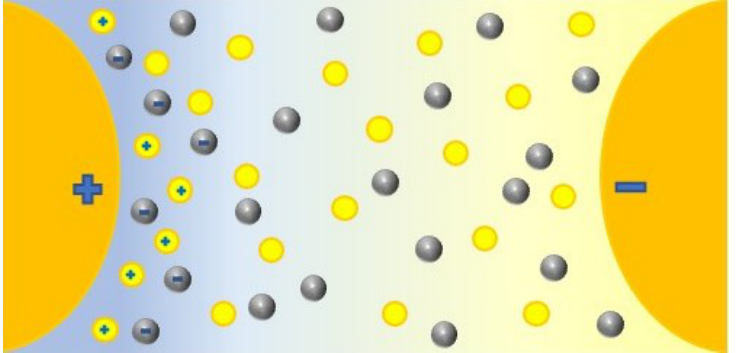
Figure 12. Capture of electrons by nanoparticles and delay of the streamer.